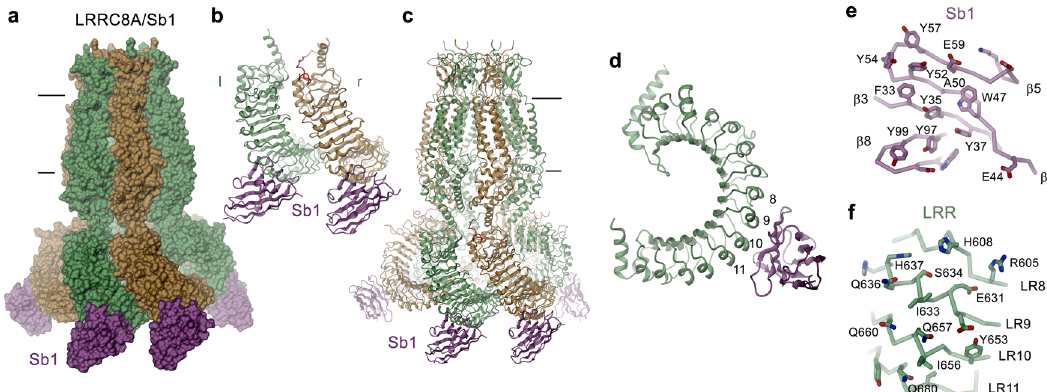
Fig. 4 Structure of LRRC8A in complex with the inhibitory sybody Sb1. a Surface representation of the LRRC8A/Sb1 complex structure. b Structure of the dimer of interacting domains at the tight interface with bound sybody Sb1. Left (l) and right (r) positions are indicated. c Ribbon representation of the LRRC8A/Sb1 complex. a , c The view is from within the membrane with membrane boundaries indicated. d Ribbon representation of a single LRR domain with sybody Sb1 bound. Repeats contacted by Sb1 are labeled. e View on the interaction interface of Sb1 and f the LRRC8A domain. The protein is shown as C α trace with the sidechains of interacting residues displayed as sticks.